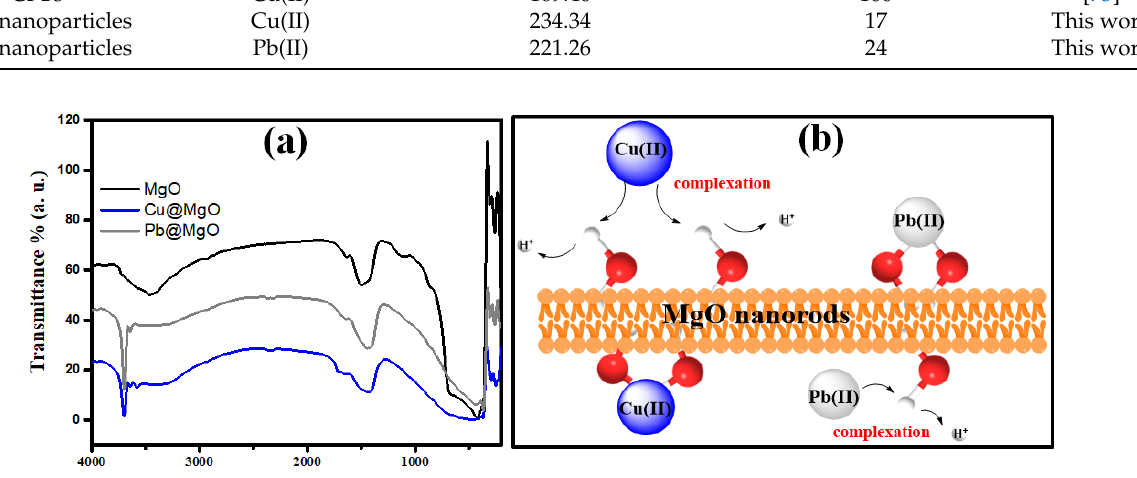
Figure 8. ( a ) FTIR spectra of Cu@MgO, Pb@MgO and MgO nanorods, ( b ) proposed adsorption mechanism of Cu(II) and Pb(II) ions onto MgO nanorods.